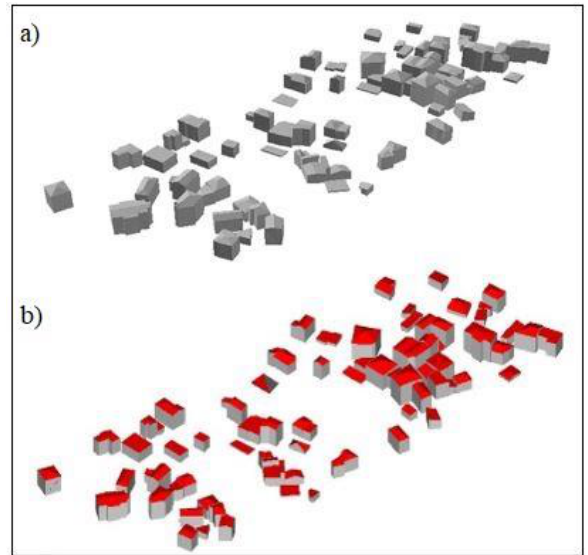
Figure 8. a) Visualization of LOD2 buildings in ArcScene and b) in FZK